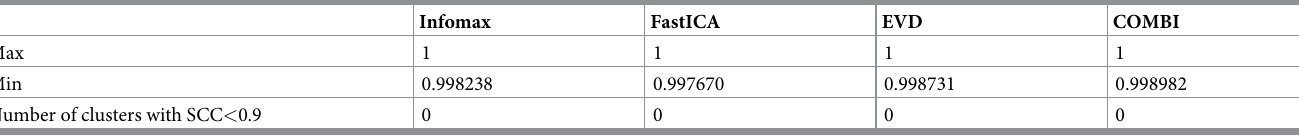
Table 9. Range of SCC values between the most reliable ICASSO results and the other nine results (motor